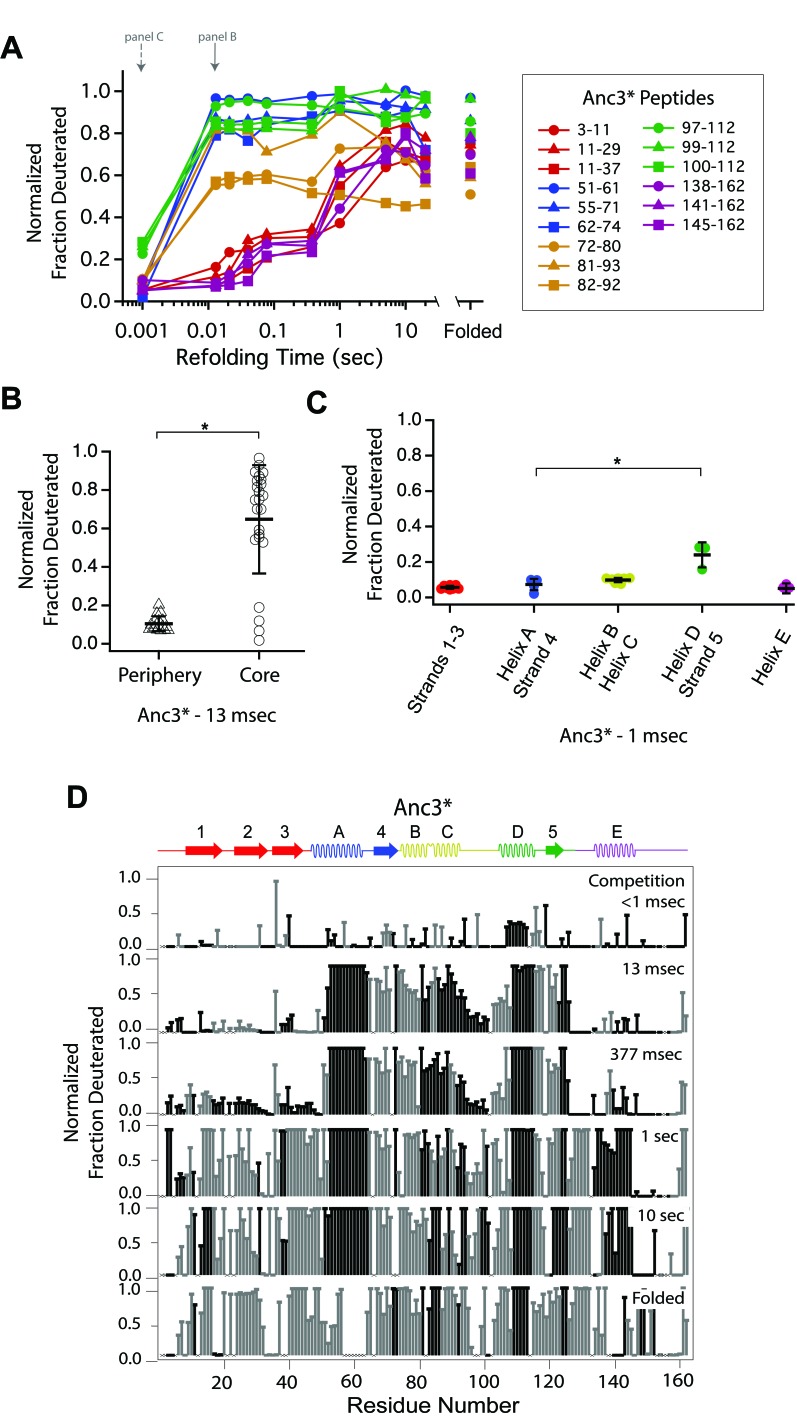
Determination of the folding pathway of Anc3* by HX-MS.(A) Protection of representative peptides from Anc3* at various refolding times. Peptides are colored according to their corresponding structural element. The solid arrow indicates the refolding time point analyzed in panel B. The dotted arrow indicates the refolding time point analyzed in panel C. (B) Protection of peptides mapping to the core region (Icore) or the periphery region of Anc3* at 13 msec after refolding. Bars represent the mean and standard deviation of each data set. *p<0.0001 (Welch’s unpaired T-test) (C) Protection of peptides of Anc3* mapping to distinct secondary structural elements at one msec after refolding. Bars represent the mean and standard deviation of each data set. *p=0.0419 (Welch’s unpaired T-test). Data for B and C represent aggregate data from three separate experiments. (D) Residue-resolved folding pathway of Anc3* at representative refolding time points. Data points in black indicate residues that are site-resolved. Data points in grey indicate residues in regions with less peptide coverage and are thus not site-resolved with the neighboring residues. Residues where site-resolved protection could not be determined due to insufficient peptide coverage is denoted with a ‘x’.